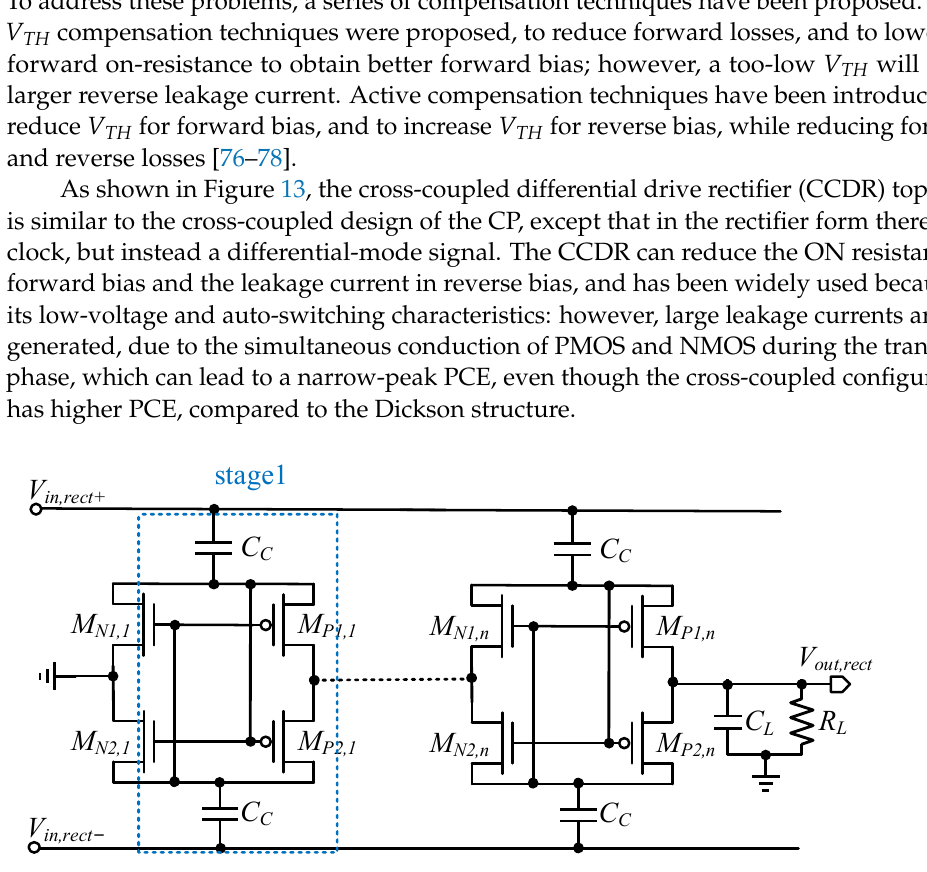
Figure 13. Cross-coupled differential drive rectifier (CCDR)